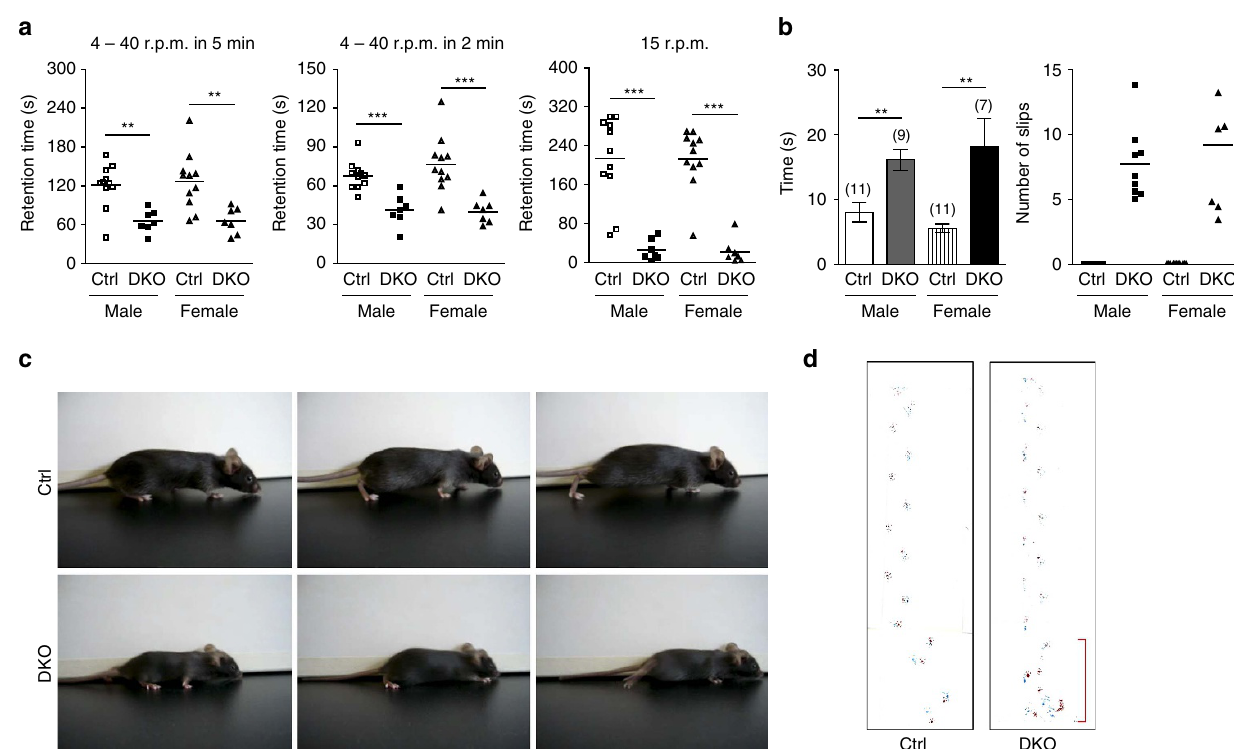
Figure 2 | Lhx1/5 DKO mutants display motor deficits. ( a ) Scatter plots showing differences in retention time before falling from an accelerating rotarod from 4 to 40r.p.m. in 5min (left) or 2min (middle) and stationary rotarod at 15r.p.m. (right) between the controls ( n ¼ 22 mice) and the DKO mutants ( n ¼ 14 mice). Bars in the scatter plots represent the mean values. ( b ) Graphs showing differences in time to complete running on an elevated balance beam (left) and number of missteps (right) between the controls and the DKO mutants. Brackets show the number of the control and the DKO mutant mice tested; t -test; ** P o 0.01 and *** P o 0.001. ( c ) Representative photos showing the walking behaviour of a control (upper panels) and a DKO mutant (lower panels). At least three mice per group were tested for their walking behaviour. ( d ) Example of paw prints acquired during footprint analysis. The DKO mutant footprint showed some tottering steps (red bracket) during initiation of locomotion. In all, 21 control mice and 17 mutant mice were